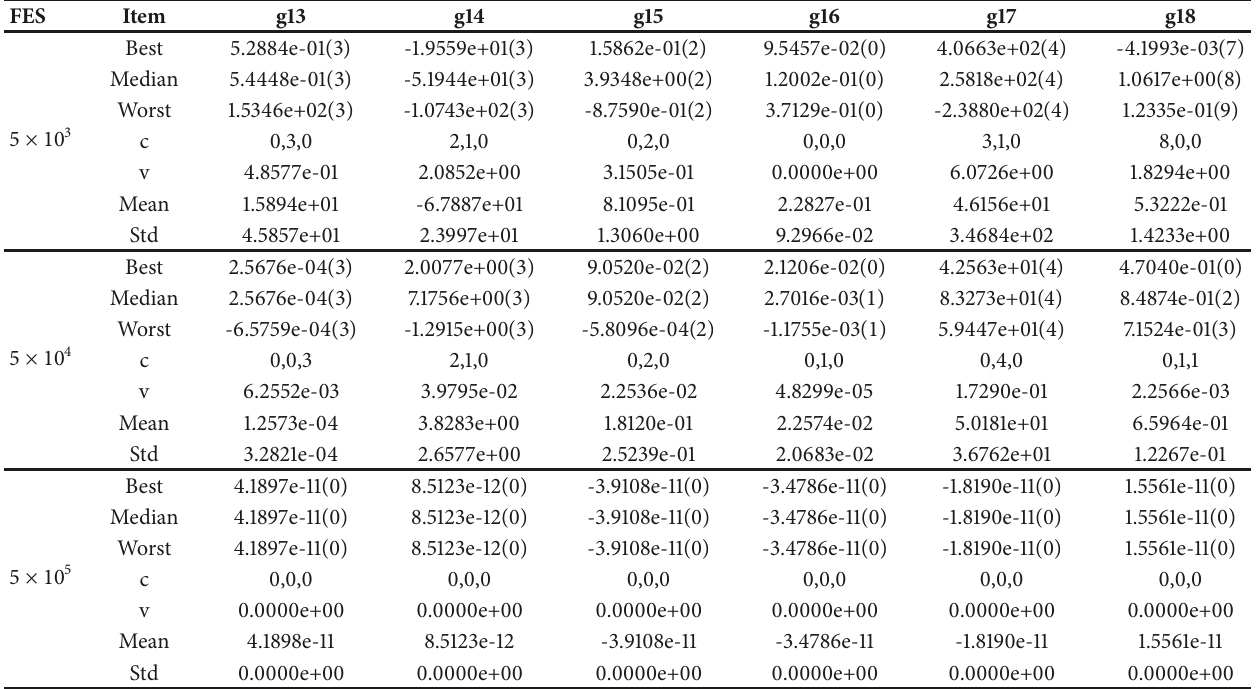
Table 4: General performance in terms of function error values achieved by CADE for test functions g13-g18.